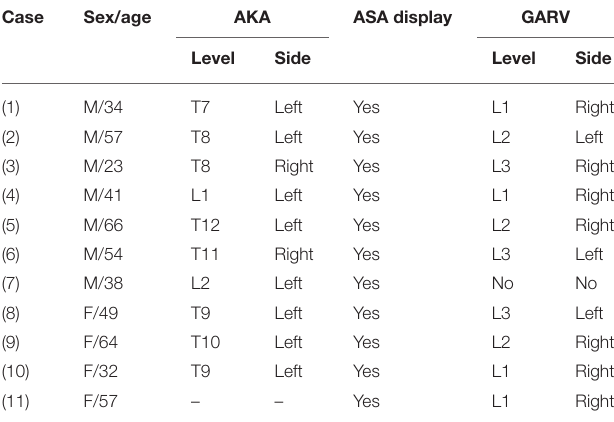
TABLE 2 | The characteristics of AKA, ASA, and GARV in negative patients on time-resolved angiography with stochastic